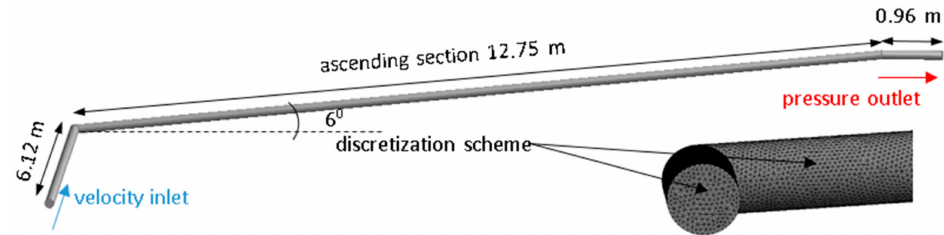
Figure 4. Geometry and method of discretization of the 3D model of the 19.83 m long installation section containing the siphon.